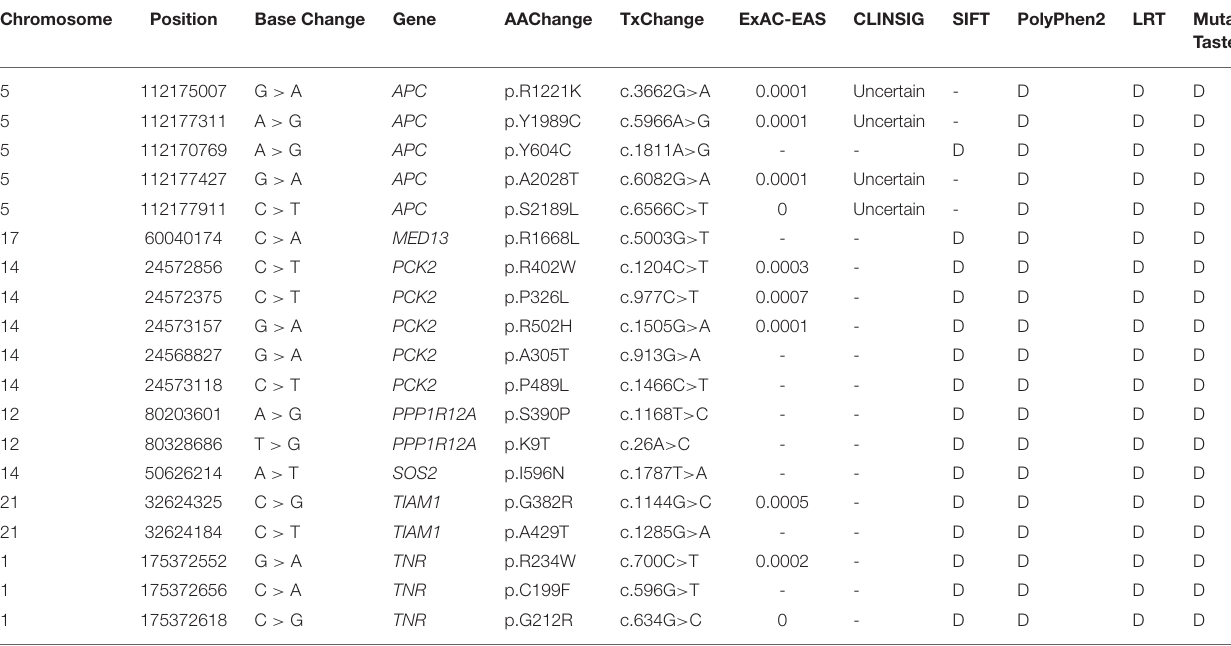
TABLE 2 | Rare variant of seven candidate genes associated with PS-PA/IVS.